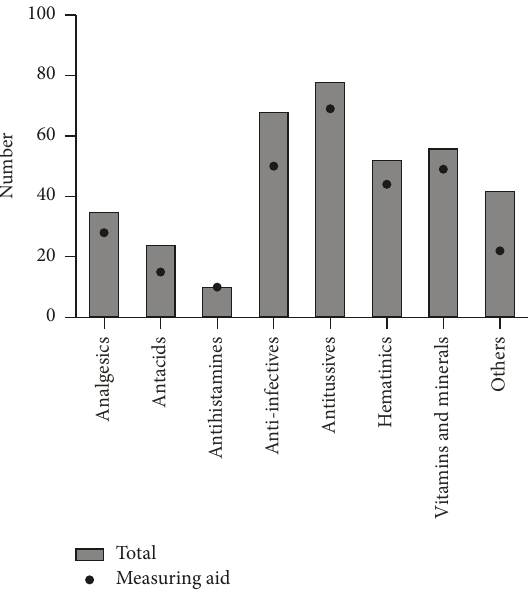
Figure 1: Availability of dosing devices packaged with various categories of oral liquid